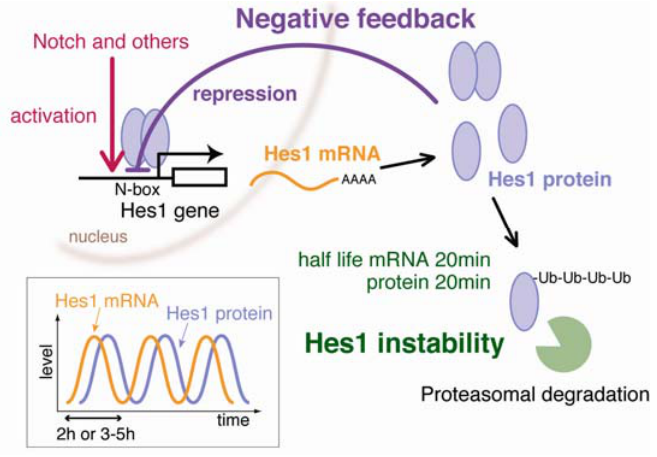
oscillate after stimulation with serum or basic fibroblast growth factor (bFGF) in cultured mouse fibroblast cells with a periodicity similar to that of Hes1 oscillation [15,16], and thus these oscillatory signaling molecules could regulate Hes1 oscillation. Figure 1. Hes1 gene expression oscillation is regulated by negative feedback and instability of gene products. Activation of the Hes1 promoter (red) induces synthesis of both Hes1 mRNA (orange) and protein (blue). Hes1 protein then binds to N box sequences of the Hes1 promoter and represses its own expression (purple). This repression leads to disappearance of Hes1 mRNA and Hes1 protein because they are extremely unstable. Hes1 protein is degraded by the proteasome (green). Disappearance of Hes1 protein relieves negative autoregulation, allowing the next round of expression. As a result, Hes1 expression oscillates in individual cells (inlet). The periodicity of Hes1 oscillation is about 2 h in fibroblast cells and about 3–5 h in ES cells.